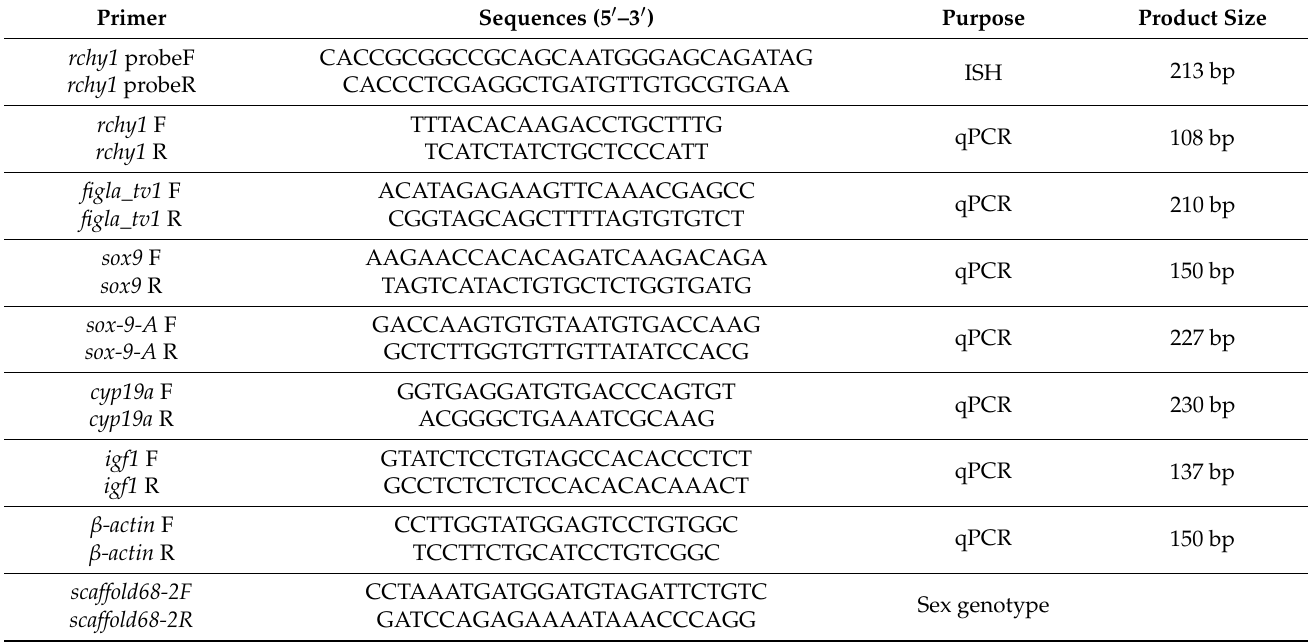
Table 1. Primer sequences used in this